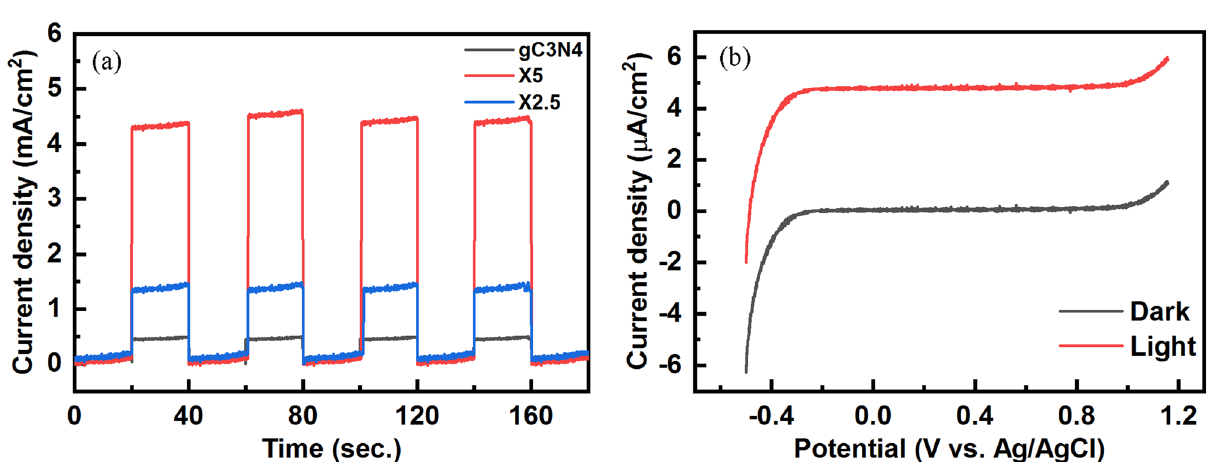
Figure 8. ( a ) Photocurrent versus time under a chopped condition at a constant applied bias of + 0.5 V and ( b ) LSV plot of the X5 composite sample in dark and under